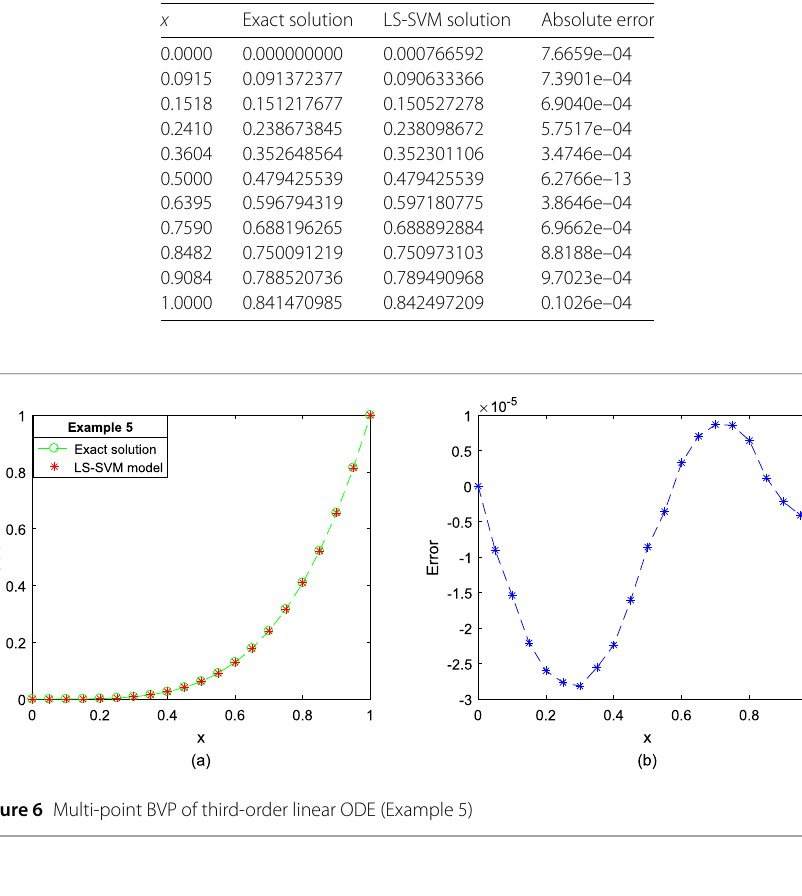
subject to multi-point boundary conditions y (0) = 0, y (cid:6)(cid:6)(cid:6) (0.25) = 6, y (cid:6)(cid:6) (0.5) = 3, y (1) = 1. The analytic solution is y = x 4